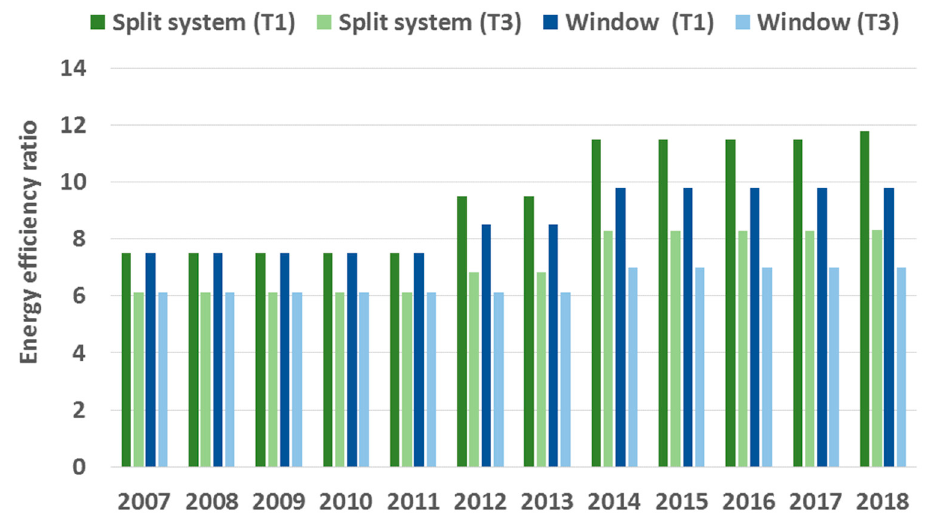
Figure 2. Evolution of energy efficiency ratio (EER) Standards in Saudi Arabia. Source: Authors, based on [42,43] and the Saudi Arabian Standards Organization (SASO). Note: T1 = 35 °C, T3 = 48 °C refers to the test conditions at dry-bulb temperature.